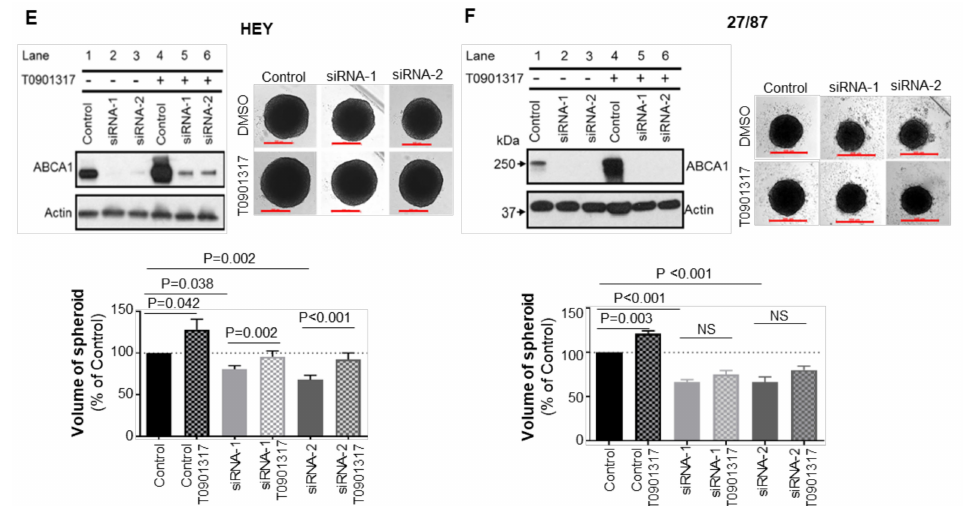
Figure 3. ABCA1 suppression reduced the size of epithelial ovarian cancer (EOC) spheroids. ( A ) Representative photographs (left panels) and column graphs (right panels) showing the effect of ABCA1 suppression on the size of HEY and 27/87 EOC spheroids at 72 h after seeding into low-adhesion plates and 96 h after transfection. n = 3. p -Values were derived from one-sample t -tests. ( B ) Changes in the number of cells per spheroid after ABCA1 suppression in HEY and 27/87 cells. Assays performed at the same time as for ( A ). n = 3. p -Values were derived from one-sample t -tests. ( C ) Representative photographs (left panels) and column graphs (right panels) showing the effect of ABCA1 suppression on the size of WEHI-CS62 patient-derived, high-grade serous EOC spheroids at 72 h after seeding into low-adhesion plates and 96 hours after transfection. n = 3. p -Values were derived from one-sample t -tests. ( D ) The effect of ABCA1 overexpression, achieved using T0901317, on WEHI-CS62 spheroid size. n = 3. p -Values were derived from unpaired, two-tailed t -tests. ( E ) The effect of ABCA1 re-expression, achieved using T0901317, on HEY spheroid size. n = 3. ( F ) The effect of ABCA1 re-expression, achieved using T0901317, on 27/87 spheroid size. n = 3. All results represent the mean ± SD. p -Values derived from one-way ANOVA with Dunnett’s multiple comparison tests. Scale bars represent 500 µ